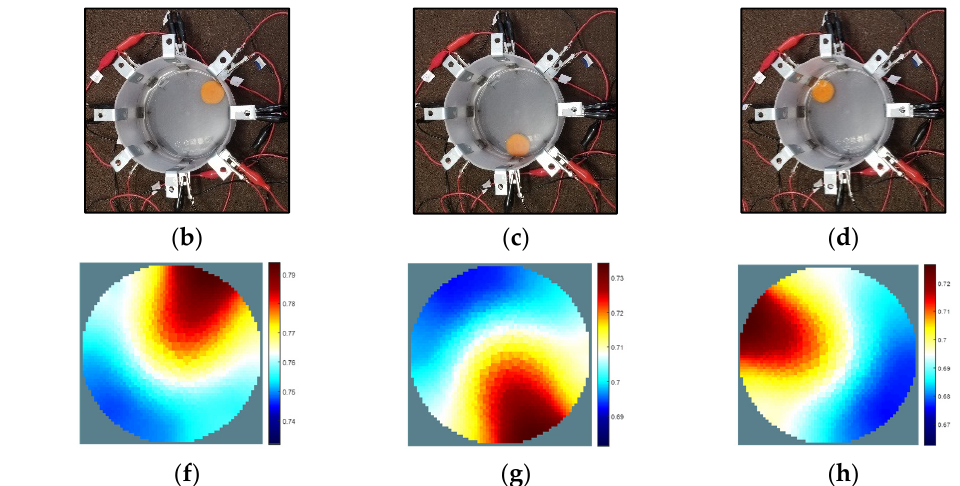
Figure 10. A carrot slice at different positions of ( a ) pos: centre, ( b ) pos: 1, ( c ) pos: 4, and ( d ) pos: 7 in the EIT domain. ( e – h ) The corresponding reconstructed images for 80 kHz, 1 mA, and Laplace ( λ = 0.57). The obtained conductivity is high at the side wall, and it is low at the centre. Further, the stimulation current was varied for a domain with a carrot slice at position 1 and the new reconstructed results were obtained as shown in Figure 11. The conductivity was increased from 0.77 to 0.85 S/m with the increase in current from 0.5 to 2 mA for a constant hyperparameter value of λ = 0.57. The reconstructed results were also obtained by varying hyperparameter values of 0.97, 0.57, and 0.17, respectively, at 1 mA for a domain with a carrot slice at position 7 as shown in Figure 12. The conductivity was increased from 0.71 to 0.9 S/m with the decrease in the hyperparameter value.